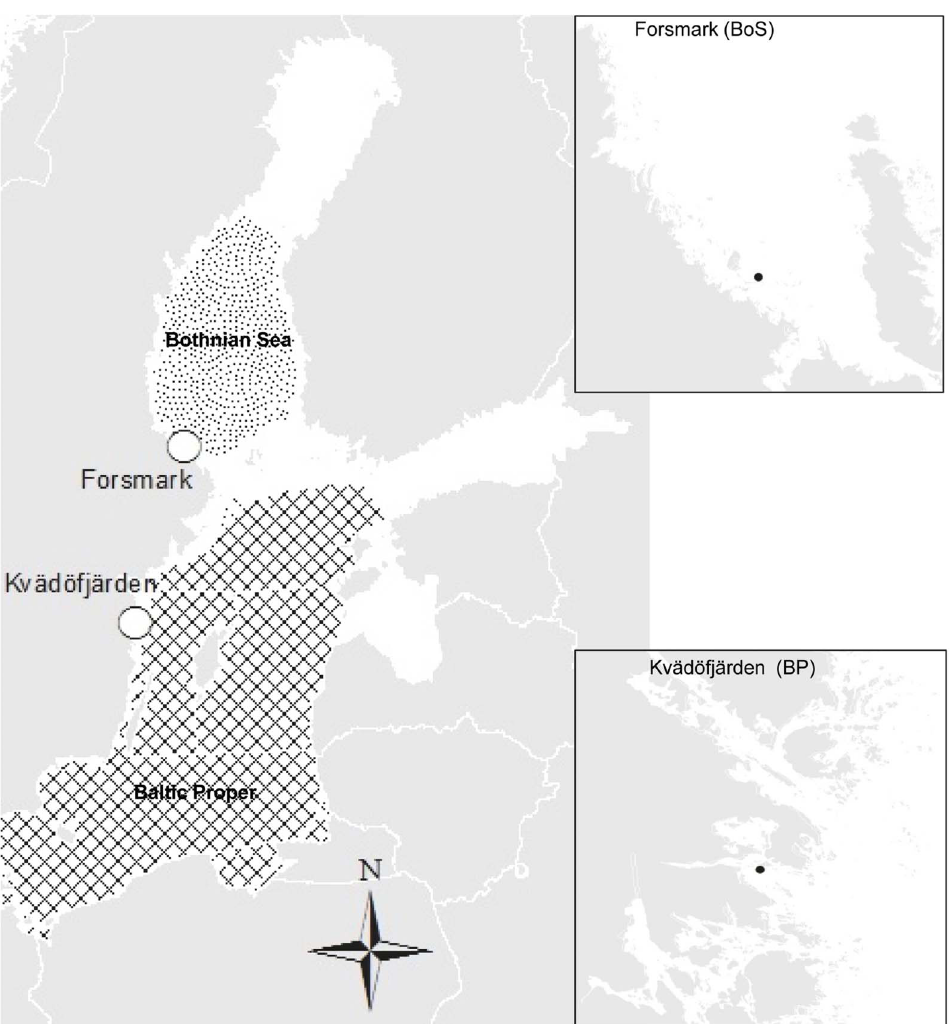
Figure 1. Location of the two areas for zoobenthos sampling. Kva¨do¨fja¨rden (Baltic Proper, BP) and Forsmark (Bothnian Sea, BoS).